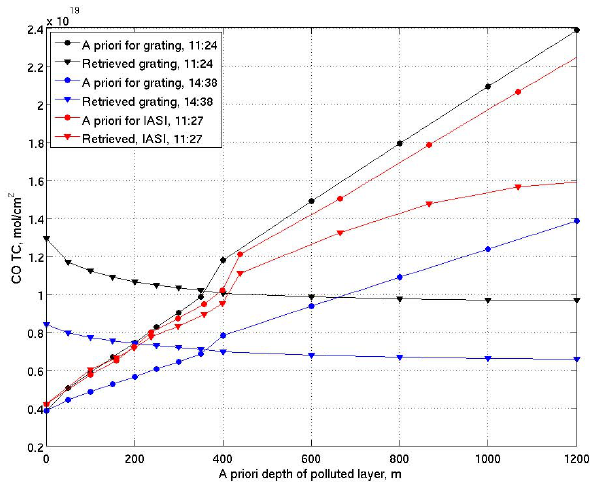
Fig. 9. Moscow, 9 August 2010. Ground-based grating total columns for CO a priori profiles (circles) and retrieved TC (trian- gles) before noon (11:24) and after noon (14:38). A priori profiles differ by the depth of polluted air with VMR 7 and 3.5ppm. In- tersections of lines of the same color (blue and black) correspond to the most probable depths of polluted air and the retrieved TC. IASI-SFA (red) does not ensure a definite